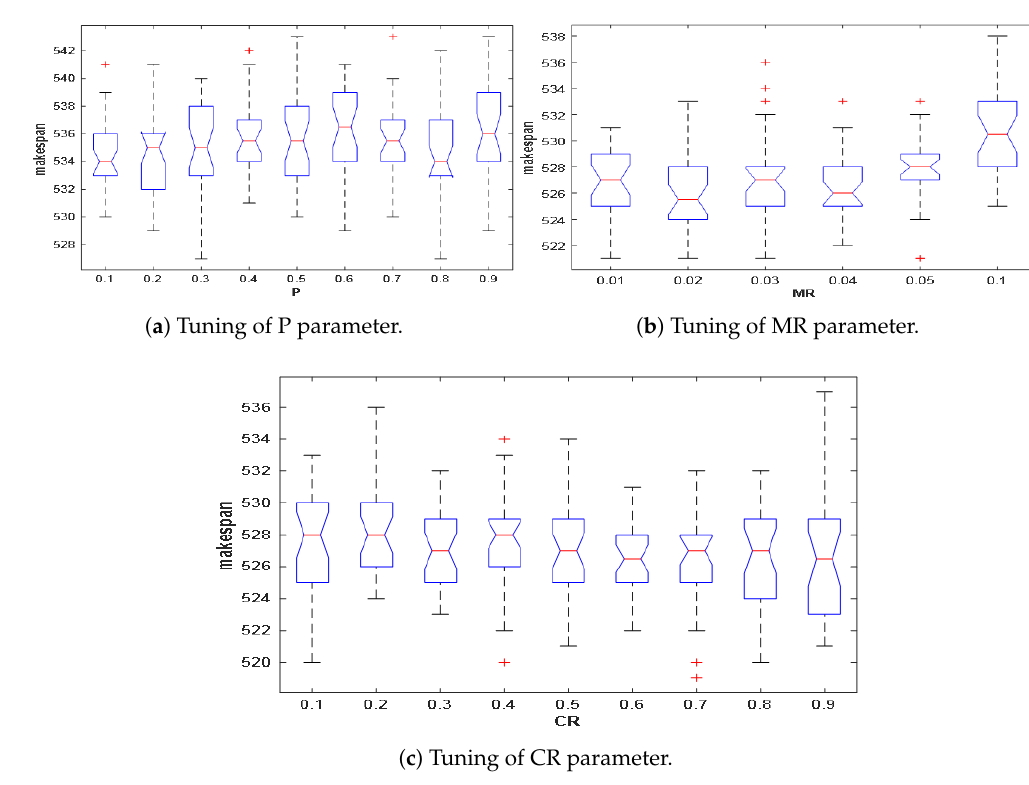
Figure 3. The sensitivity analysis for the genetic parameters